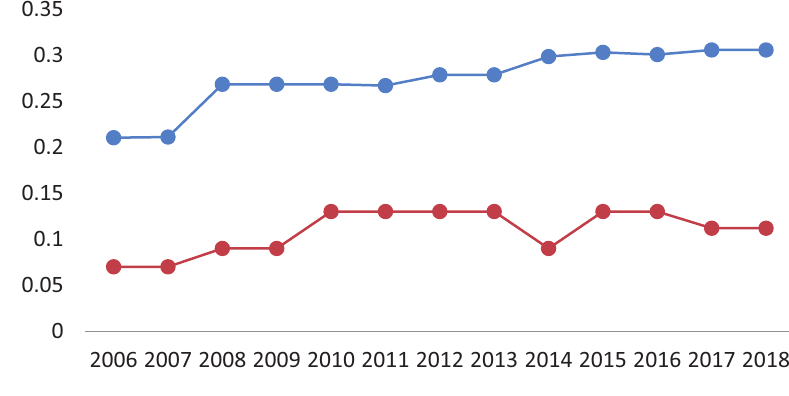
Figure 9. Time series comparison of index in women in in ministerial positions. Source: WEF (2006, 2008–2018).